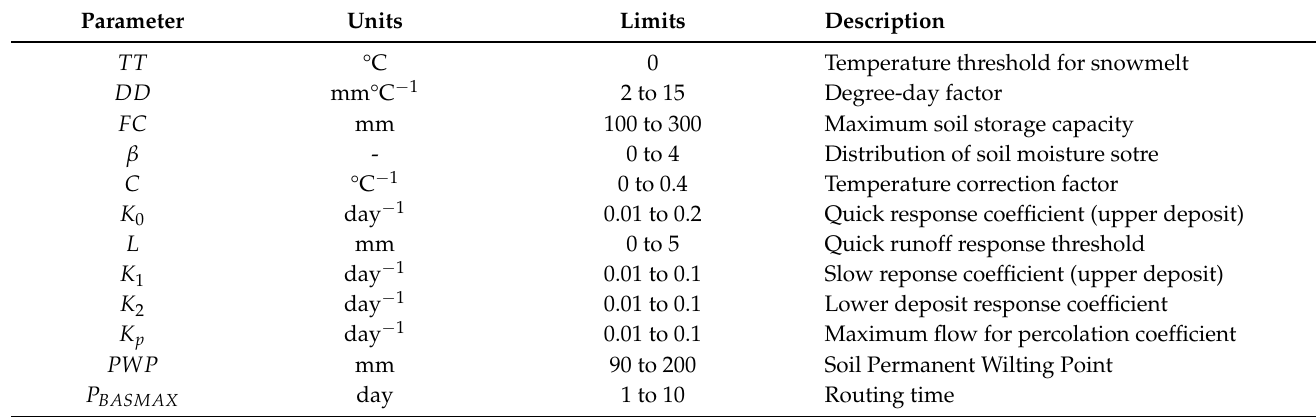
Table 5. Description of main parameters of HBV